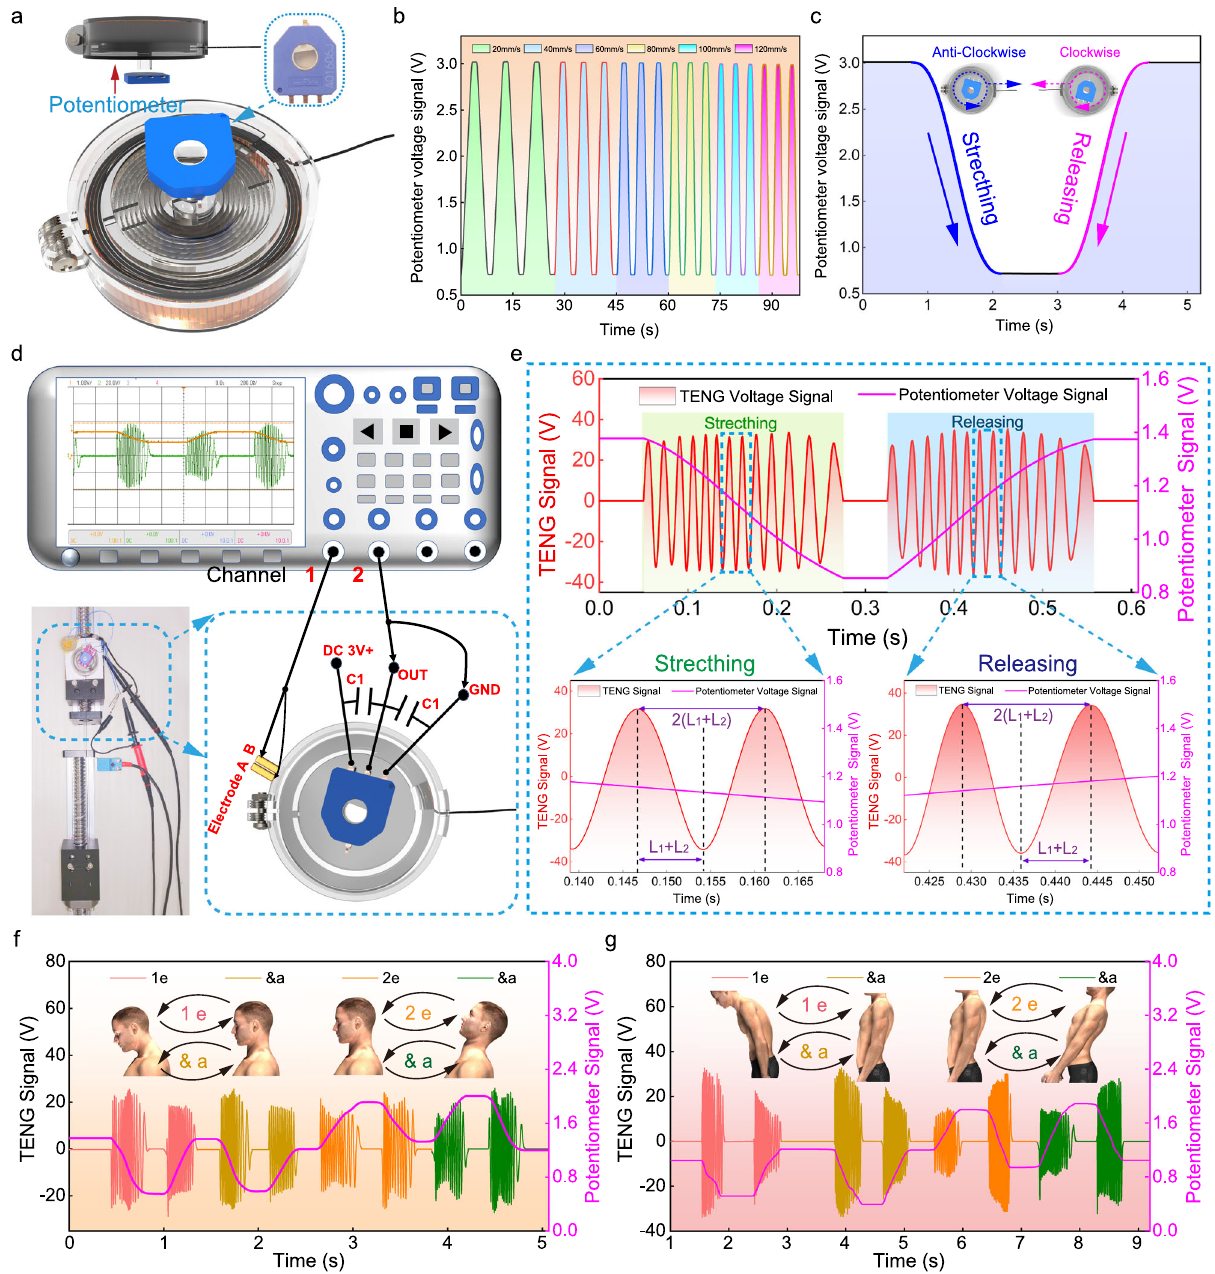
Fig. 4 Schematic diagram and electrical characteristics of the vector stretch sensor. a 3D structure diagram of the vector stretch sensor. b The voltage output performance of the potentiometer at different stretching speeds under the same stretching displacement (60 mm), c Potentiometer ’ s output voltage curve under stretching, i.e., anticlockwise rotating, and releasing, i.e., clockwise rotating, with a rotating speed of 60 mm s − 1 . d Measurement circuit. e The measured output of the TENG device and potentiometer under stretching and releasing, the two enlarged images below indicate the displacement calculation. f , g Monitoring the signal outputs via the vector stretch sensor when the participant does some exercises, including neck/ thoracic exercise gymnastics. Source data are provided as a Source Data fi